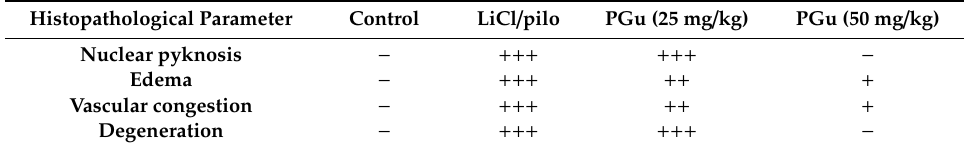
Figure 4. Photomicrographs of cerebral cortex neurons stained with hematoxylin and eosin ( A ), immunohistochemical staining showing Cyclooxygenase-2 (COX-2) ( B ) and Inducible nitric oxide synthase (iNOS) ( C ) expression in animals of the normal control group ( 1 ), pilocarpine status epilepticus group ( 2 ), PGu (25mg/kg b.w.) ( 3 ), and PGu (50 mg/kg b.w.) ( 4 ) pretreated groups with 40× magnification power. Table 3. Scoring of the histological changes among di ff erent